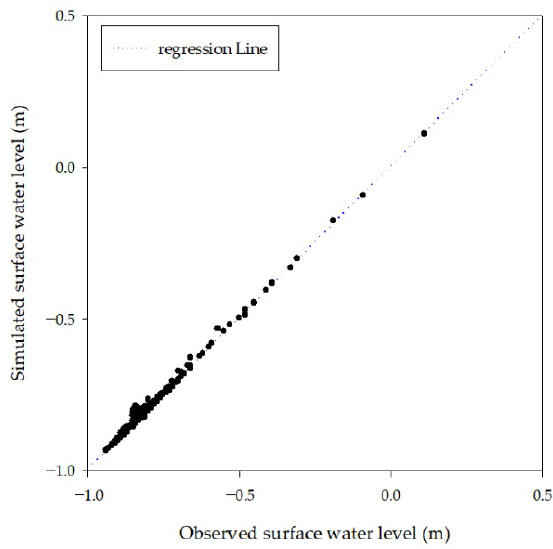
Water 2020 , 12 , x FOR PEER REVIEW Figure2. ResultsoftheEFDCmodelcalibrationforthesurfacewaterlevelinKangnungNamdaeStream. Figure 2. Results of the EFDC model calibration for the surface water level in Kangnung Namdae Stream. Table 1. Main coefficient for calibration and validation parameters used in the EFDC model.